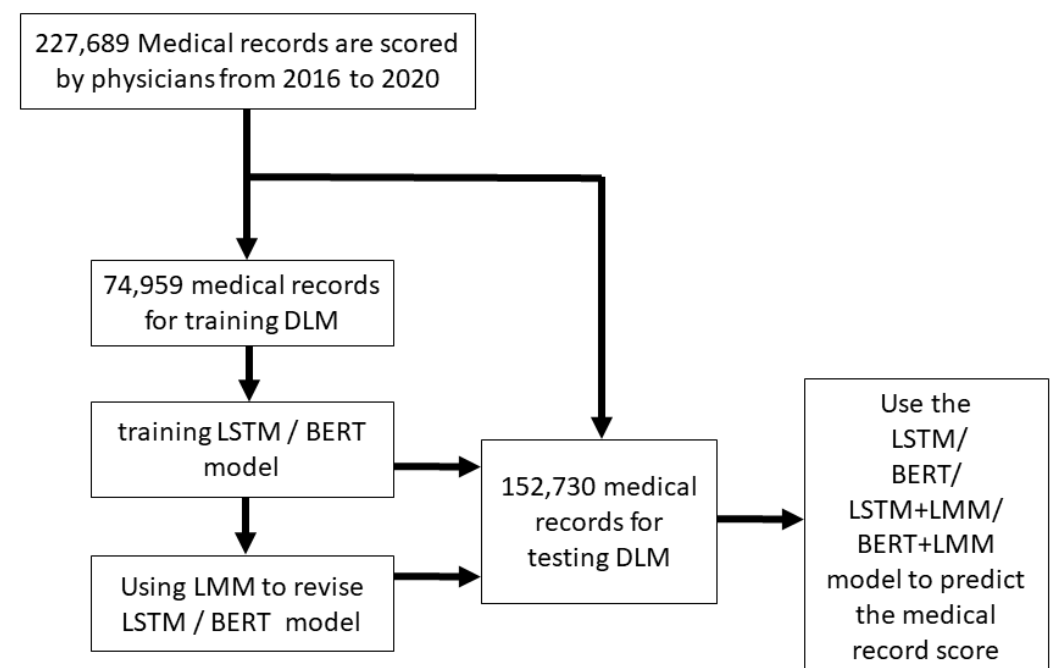
Figure 1. Training and testing sets generation. Schematic of the data set creation and analysis strategy, which was devised to assure a robust and reliable data set for training and testing of the network. Once a medical records data were placed in one of the data sets, that individual’s data were used only in that set, avoiding ‘cross-contamination’ among the training and testing sets. The details of the flow chart and how each of the data sets was used are described in the Methods.